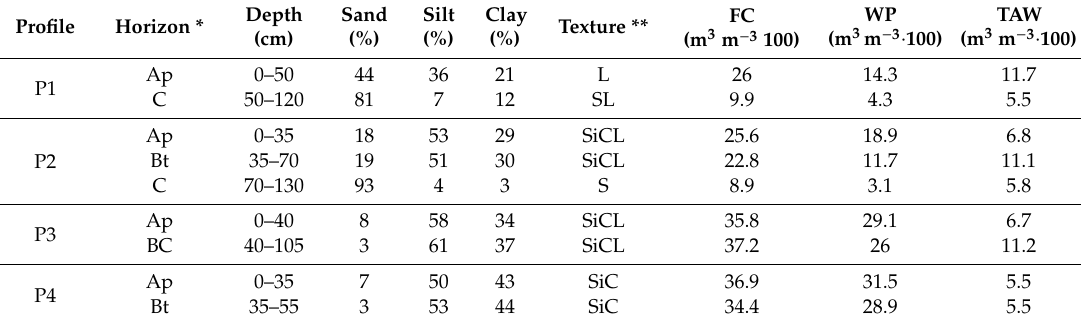
Table 1. Results of the laboratory analysis for the four profiles opened in the vineyard; for every horizon of each profile sand, silt and clay content, and volumetric water content corresponding to field capacity (FC), wilting point (WP) and total available water content (TAW) are reported.